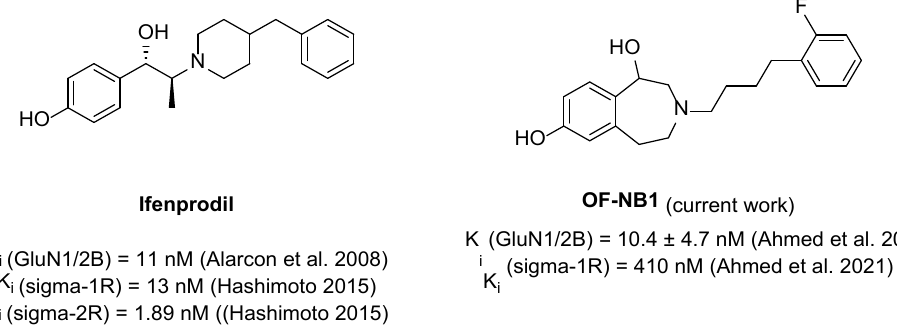
Figure 1. Left: Structure of ifenprodil, first ligand described for binding to the ifenprodil binding site of the GluN1/2B. Right: Structure of OF-NB1, a selective GluN1/2B ligand that is investigated in the current work.